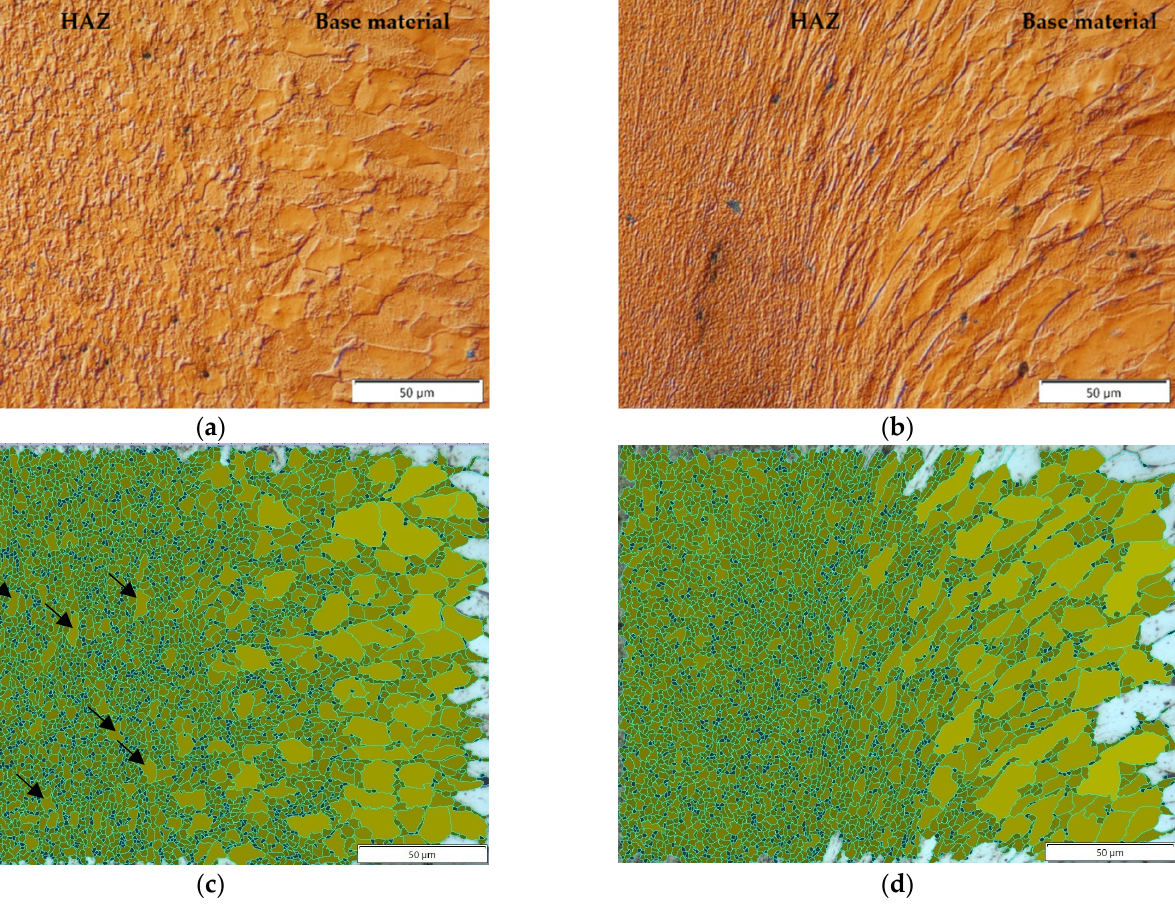
Figure 6. Microstructure of the HAZ of a high-speed friction-welded joint (observations with DIC): ( a ) on the radius, ( b ) at the axis; ( c , d ) grain size measurement corresponding to the microstructure from points a and b (measurement area: 220 µm × 160 µm).